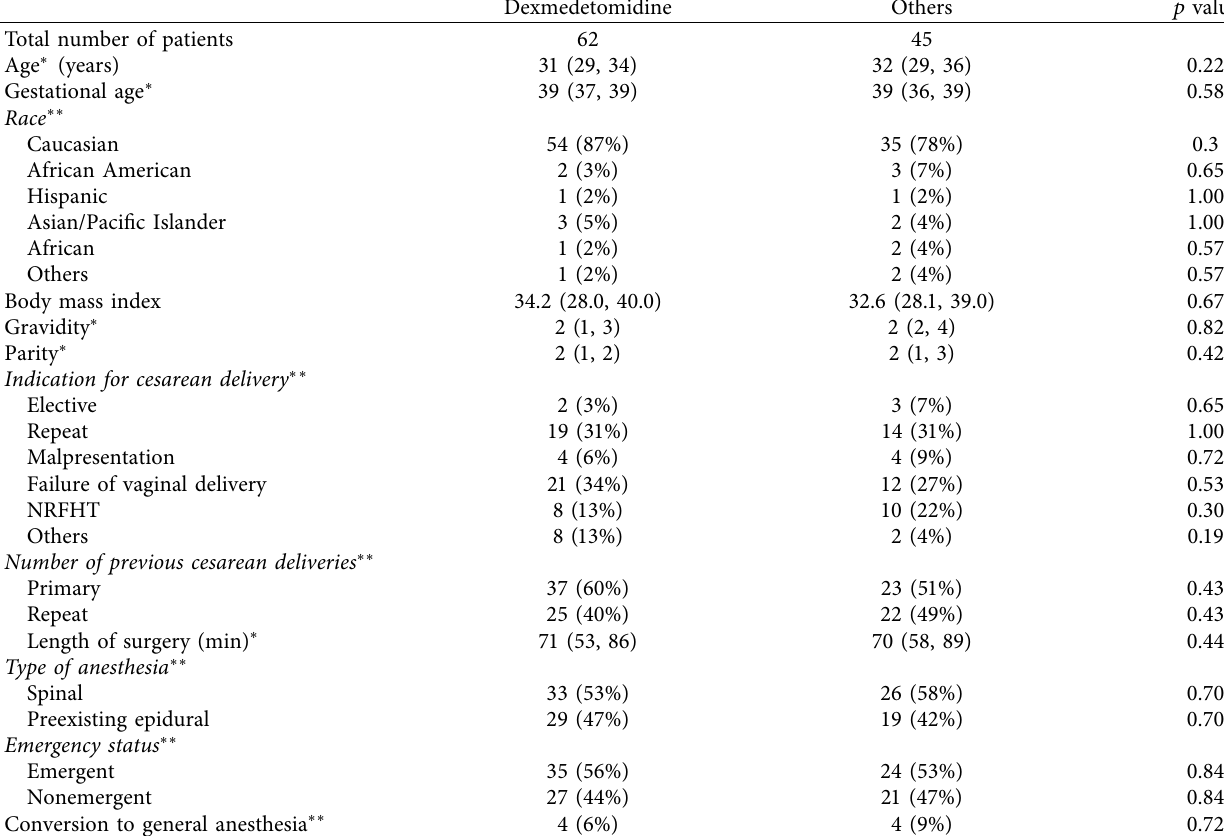
Table 1: Patient demographics and surgical characteristics.